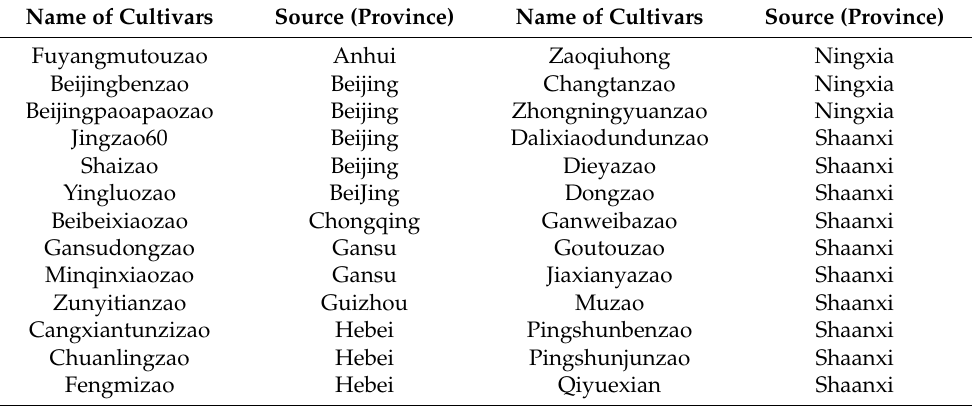
Table 1. List of 114 Chinese jujube cultivars maintained in Ningxia, China genotyped by 288 SNP markers in the present